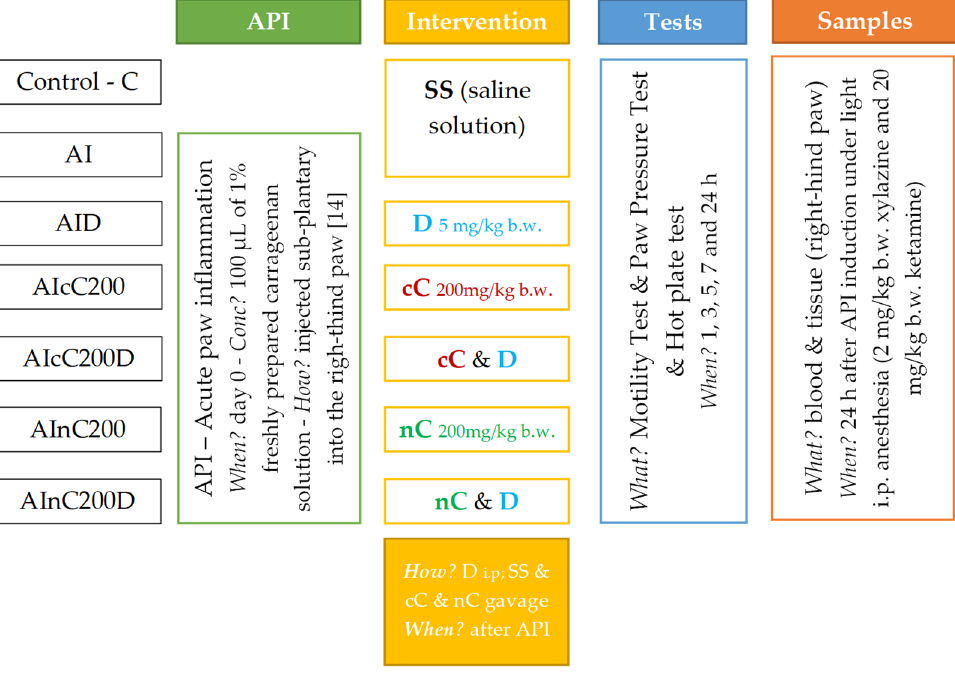
Figure 10. Flowchart demonstrating the study groups and